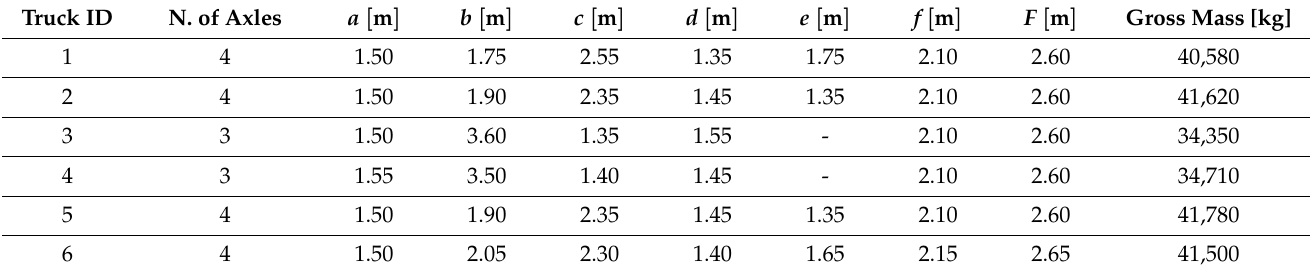
Table 4. Characteristics of the heavy trucks used for the load tests on the Longano viaduct.